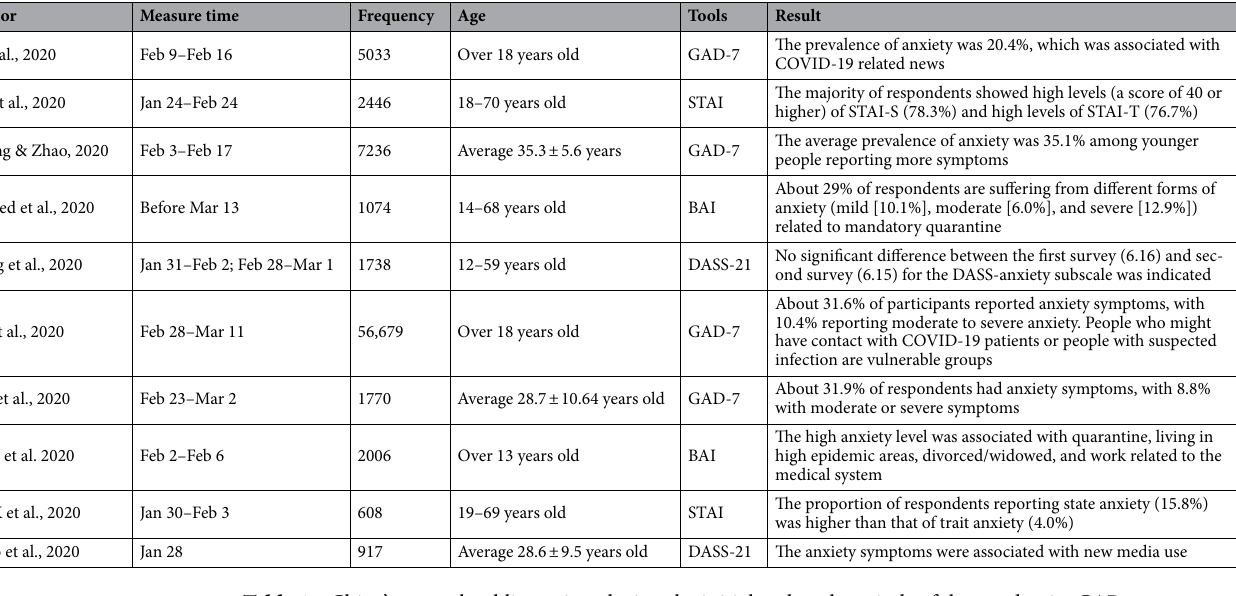
Table 1. China’s general public anxiety during the initial and peak periods of the pandemic. GAD-7 Generalized Anxiety Disorder-7, STAI State-Trait Anxiety Inventory, BAI Beck Anxiety Inventory, SCL-90 Symptom Checklist